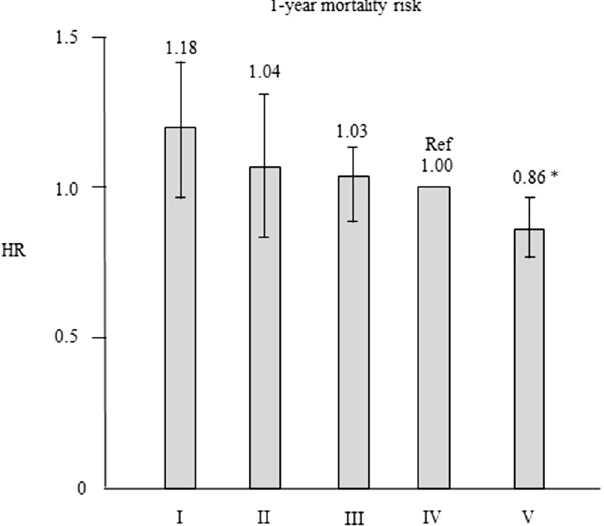
Figure 3. Hazard ratios of all-cause mortality for the 4 dialyzer groups versus the type IV dialyzer group after propensity score matching using a Cox proportional hazards regression. *P < 0.05 versus the type IV dialyzer group. Error bars correspond to 95% confidence